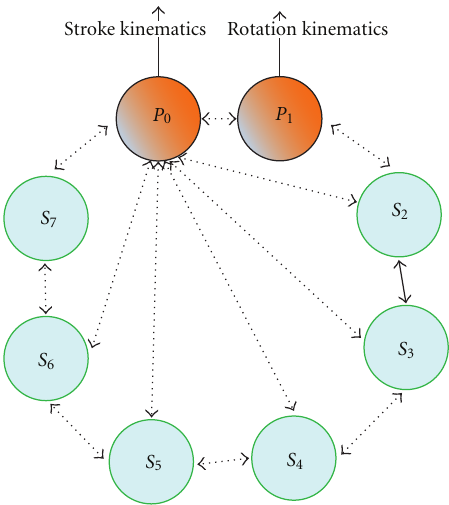
Figure 11: A pictorial representation of the fully connected eight neuron architecture of the autonomous cruise mode controller chosen for qualitative decomposition analysis. As mentioned earlier, the stroke and rotation neurons are marked “ P ” as primary and “ S ” as secondary for the other neurons and numbered accordingly from 0 to 7.